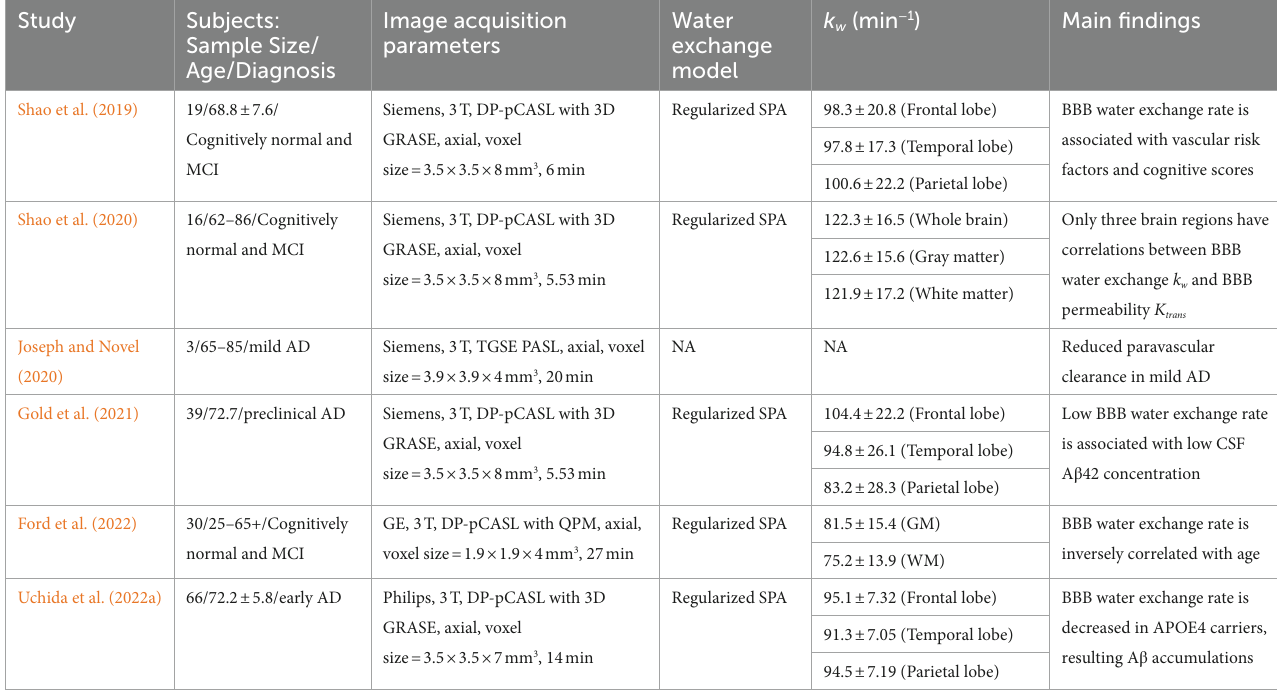
TABLE 3 Overview of ASL-based BBB imaging in subjects with the AD continuum.